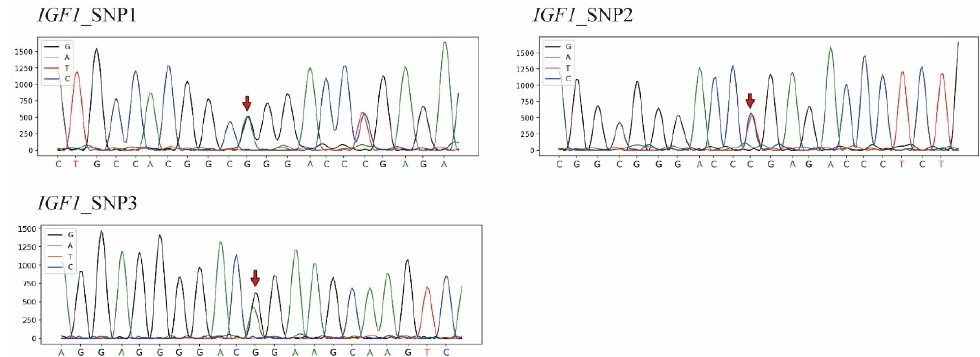
Table 1. The information of SNP in IGF1 and IGF1R in Hulun Buir Sheep